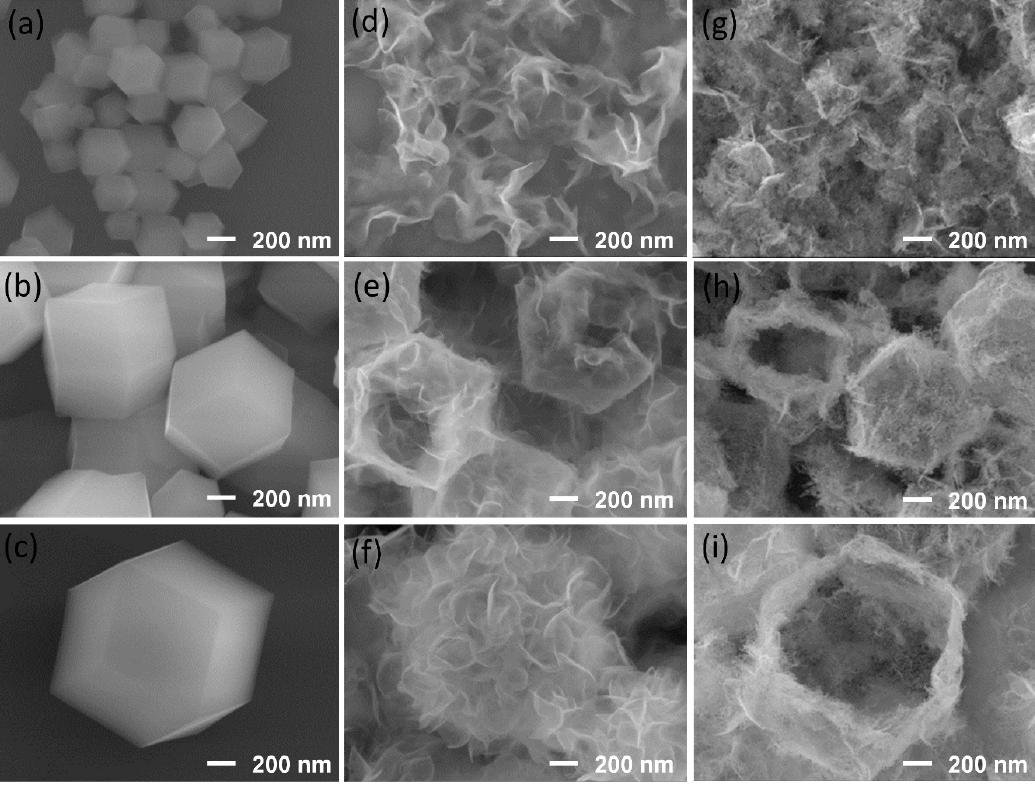
Figure 2. Scanning electron microscope (SEM) images of dodecahedral diamond zeolitic imidazolate framework-67 (ZIF-67): ( a ) ZIF-67-1, ( b ) ZIF-67-2, ( c ) ZIF-67-3; hollow Co-layered double hydroxide (Co-LDH): ( d ) Co-LDH-1, ( e ) Co-LDH-2, ( f ) Co-LDH-3; hollow Co 3 O 4 : ( g ) Co 3 O 4 -1, ( h ) Co 3 O 4 -2, ( i ) Co 3 O 4 -3.